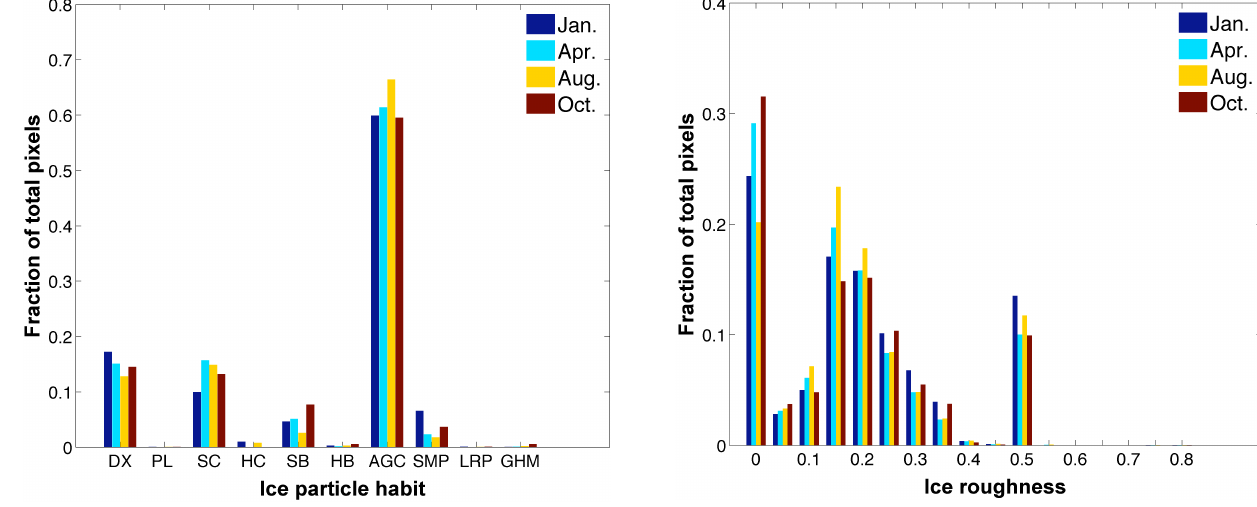
Fig. 4. Ice habit inferred for data from four different months in polar regions only, shown as a histogram of the fraction of total pixels as- signed as one of the 9 single habits or general habit mixture defined in Fig. 1.